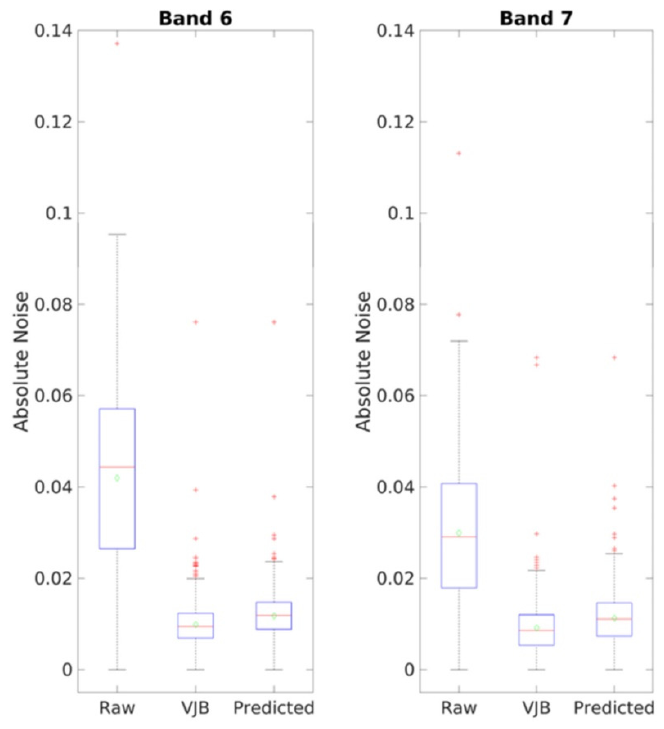
Figure 6. Time series evaluation of noise of the directional reflectance (raw) with the normalized reflectance using the VJB method and using the predicted equations. The top line of each box is the upper quartile (Q3) and the bottom line of the box is the lower quartile (Q1). The central line and the green point represent the median and the average values, respectively. The top/down whiskers denote the upper/lower adjacent value. The red crosses depict the values, which fall outside the lower/upper adjacent value interval.